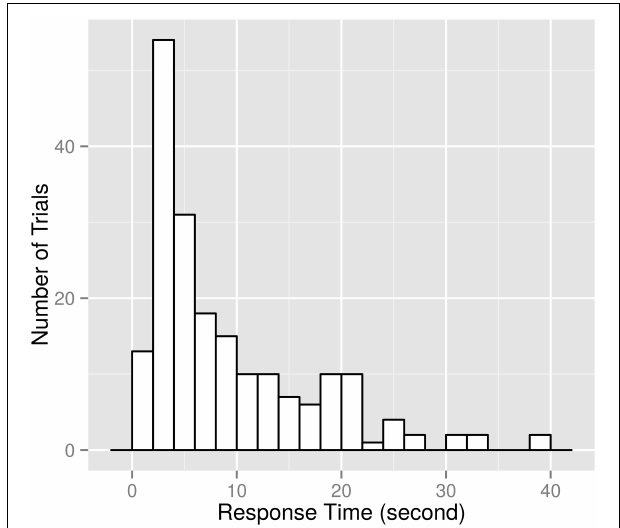
FIGURE 5 | Histogram of response times of 172 trials ( case 2 ). The horizontal axis shows response time in seconds. The vertical axis shows the number of trials. Each bin has a constant width of 2s. Seven trials in case 2 and four trials in case 1 had response times less than 2s, and thus we omitted those trials from the